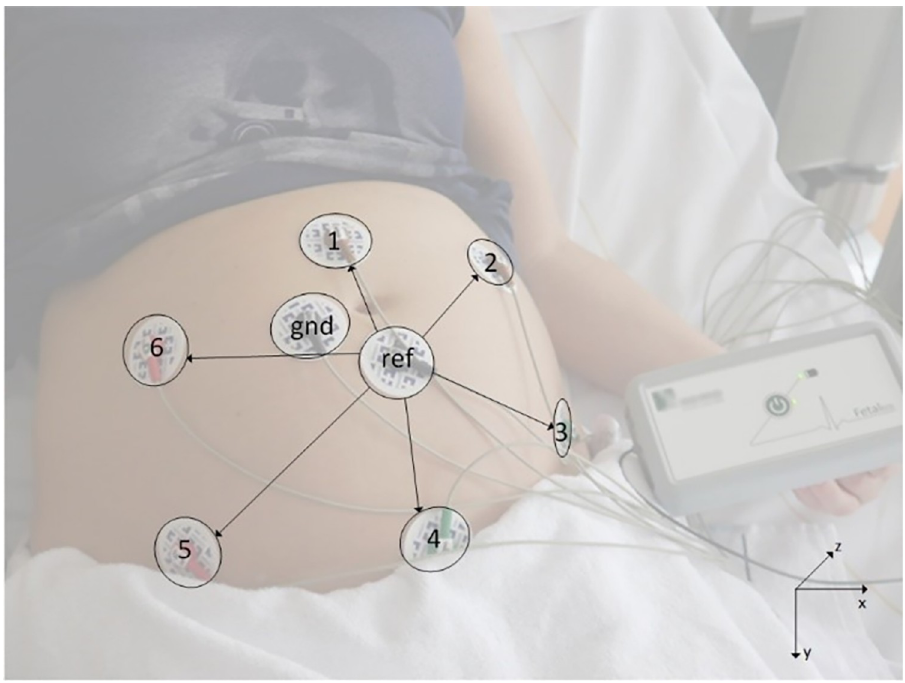
Fig 1. The non-invasive fetal electrocardiogram (NI-fECG) setup with electrodes on the maternal abdomen.